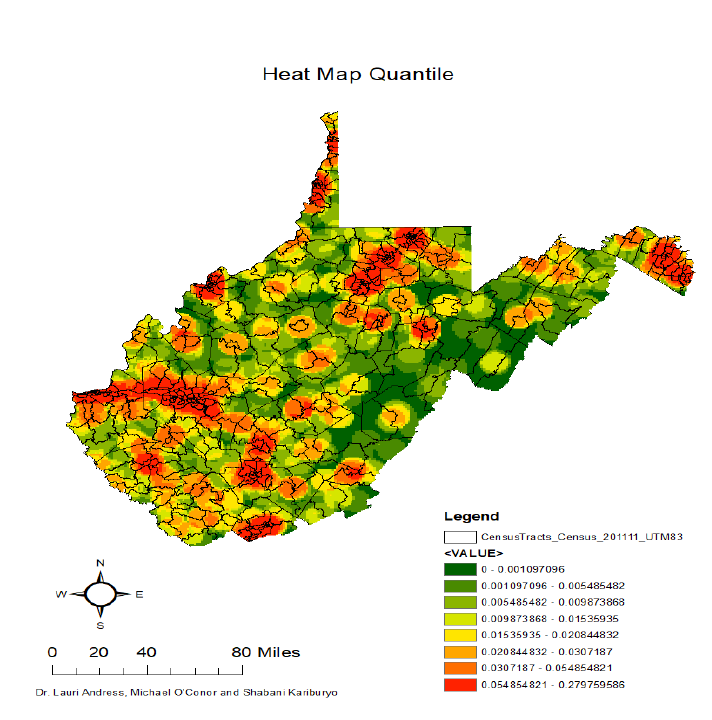
Figure A2. Heat map of food providers in West